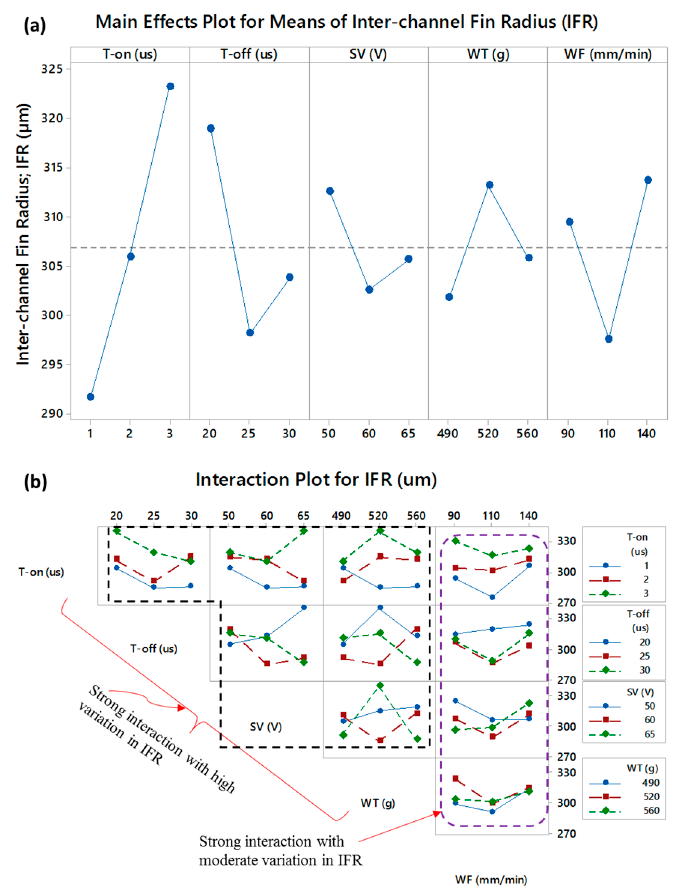
Figure 8. Parametric effects on inter-channel fin radius (IFR): ( a ) main effects plot and ( b ) interaction plot. Table 8. S/N ratio analysis of IFR (smaller is better).